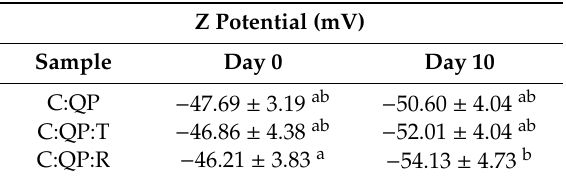
Table 1. Z potential of filmogenic suspensions.